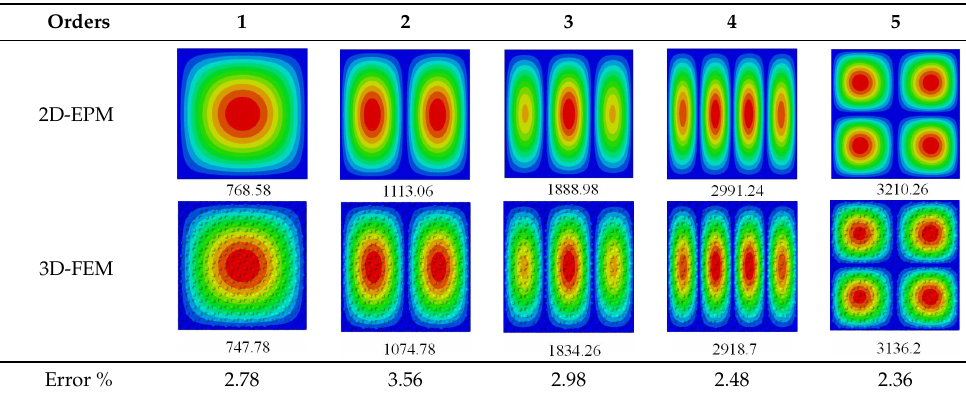
Table 6. Comparison of the first five global buckling modes and critical loads (N) of bidirectional CCCP in Case 3 predicted by different